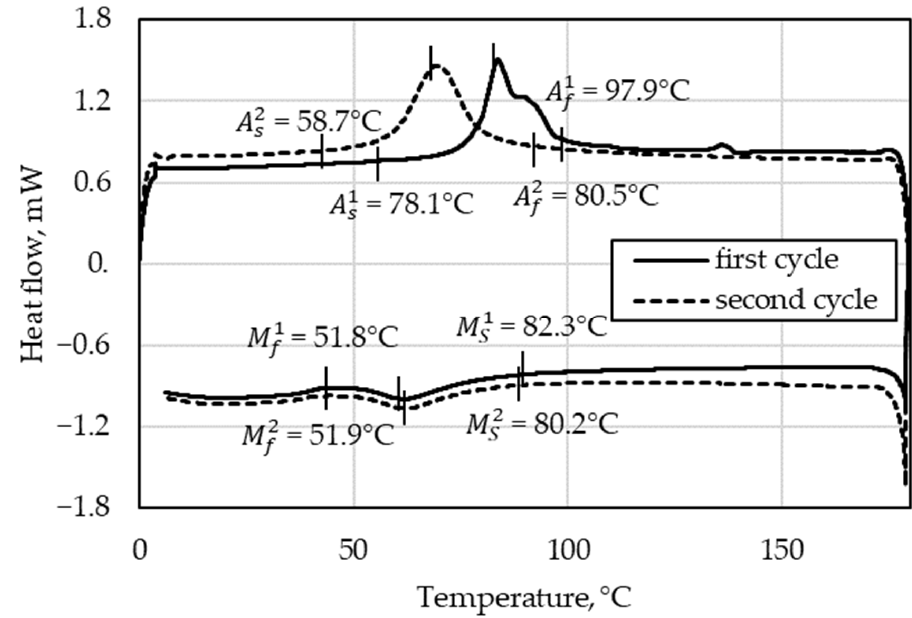
Figure 11. DSC test results of the first (superscript 1) and second (superscript 2) heating cycles of the SMA material.